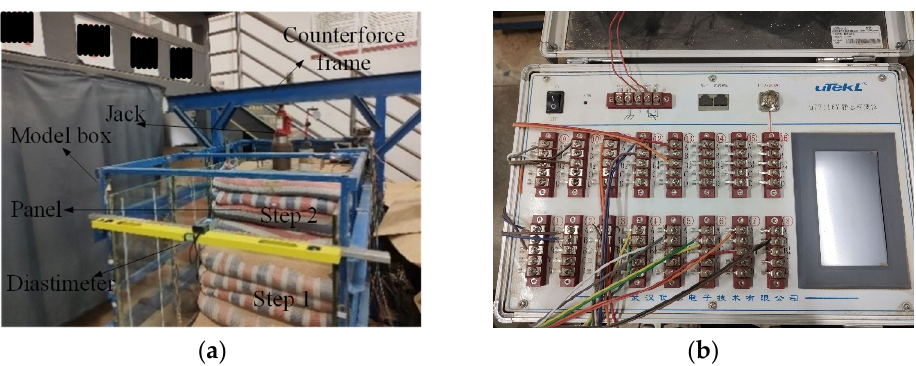
Figure 9. Model test diagram: ( a ) test site; ( b ) data acquisition instrument.